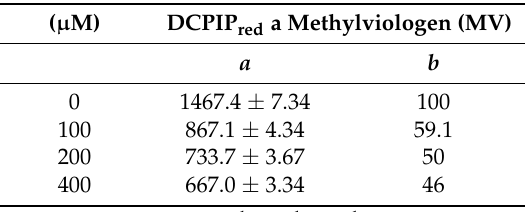
Table 3. Effects of arborinine ( 1 ) on photosynthetic uncoupled electron transport at PSI.